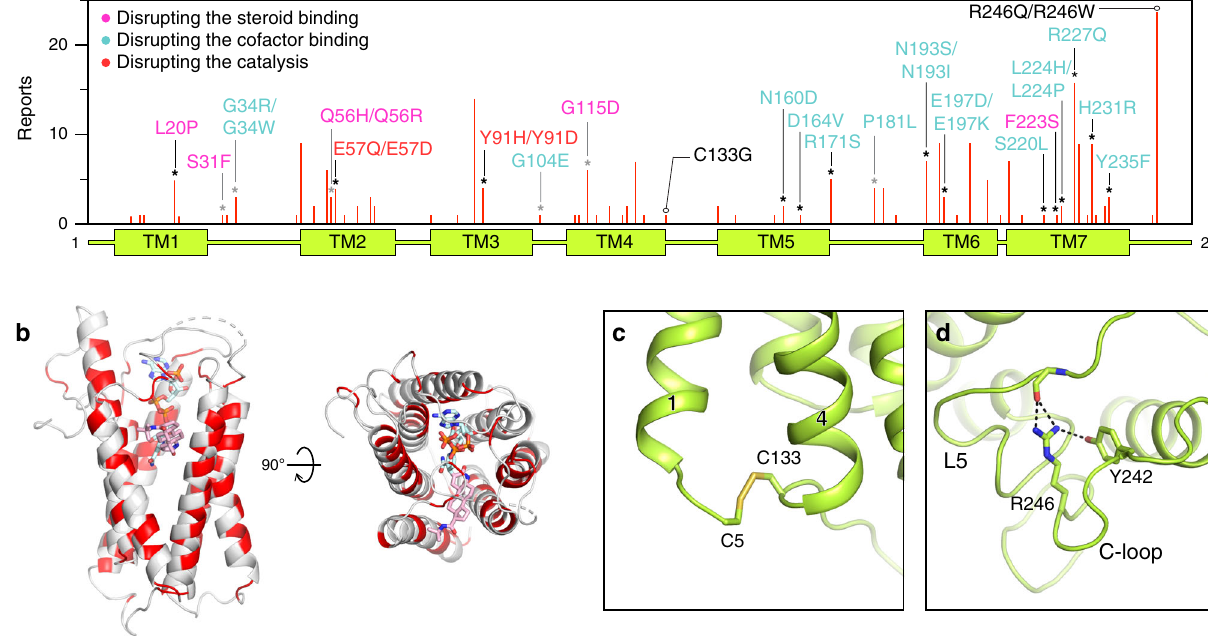
Fig. 5 Structural analysis of disease-associated missense mutations of SRD5A2. a Distribution of identi fi ed missense mutations of SRD5A2. The red bar length for each mutation site indicates how many times it was reported based on the data collected from HGMD and literature. The sites that are involved in the binding of NADP – DHF and the formation of the binding cavity are indicated by black and gray asterisks, respectively. The mutations presumably disrupting the steroid binding, the cofactor binding, and the catalysis are labeled in pink, cyan, and red, respectively. b Mapping of the mutation sites onto the SRD5A2 structure viewed from the side and the top of the transmembrane domain. The mutation sites are colored in red. c , d Environment of C133 and R246 suggesting their roles in protein